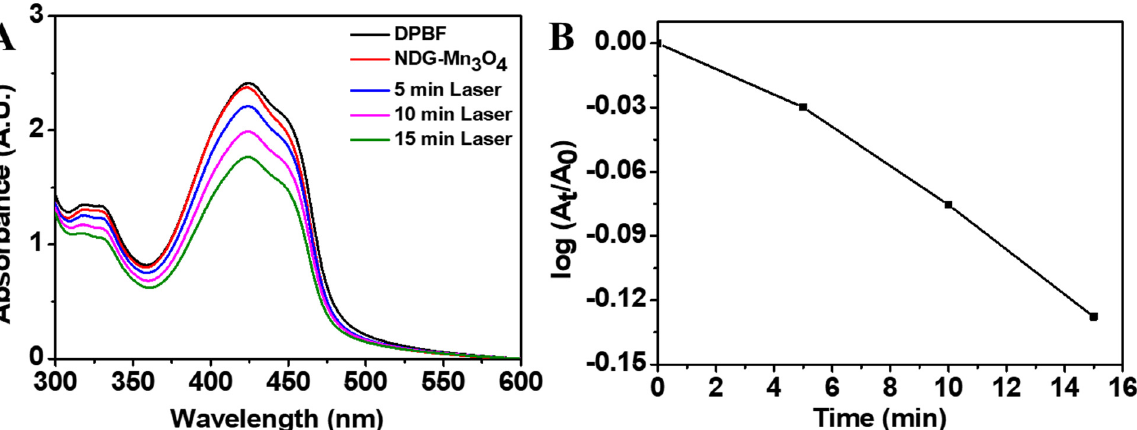
Figure 7. Time-dependent absorption spectra of 1,3-diphenylisobenzofuran (DPBF) in the presence of NDG-Mn 3 O 4 under laser irradiation ( A ). Absorbance decrease of DPBF at 426 nm at different time points under laser irradiation at room temperature ( B ). (A t = Absorbance at time t, A 0 = absorbance at time 0).